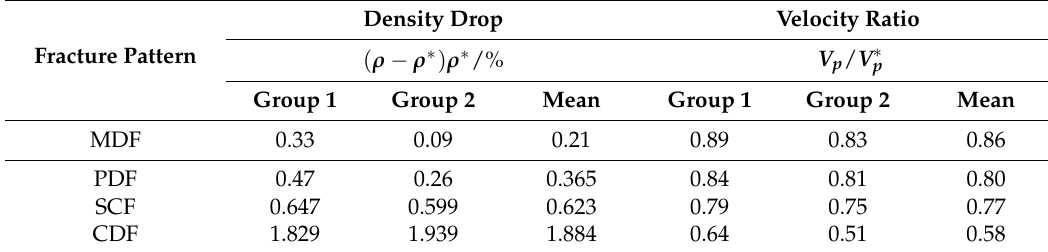
Table 4. Density drop and longitudinal wave velocity ratio.